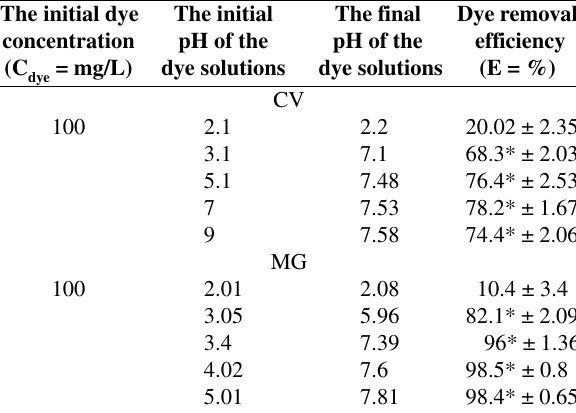
Table 2. The effect of the initial pH on CV and MG dye removal ef- ficiency with Lemna minor aquatic plants; initial pH = 2–9 for CV, = 3g (in fresh weight), C = 290 2–6 for MG; in conditions of m plants i mg/L, T = 23 ± 2 °C, until 12 days; values mean ± standard devia- tions (n = 3); *significant difference at P < 0.05.